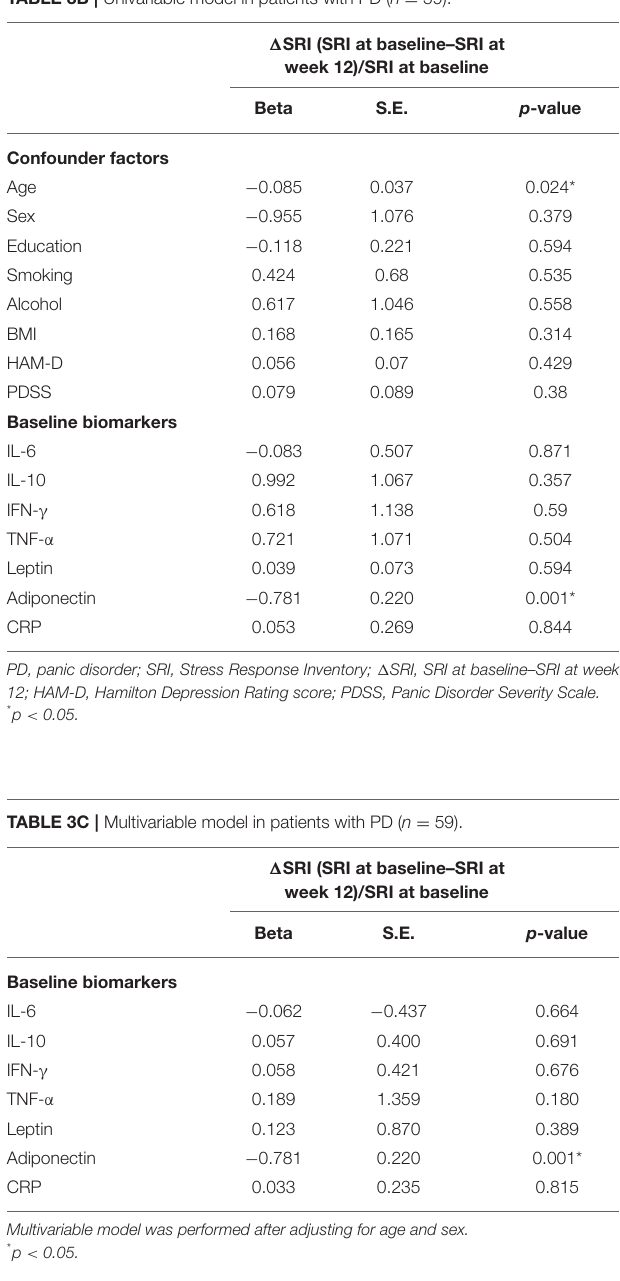
TABLE 3B | Univariable model in patients with PD ( n = 59).